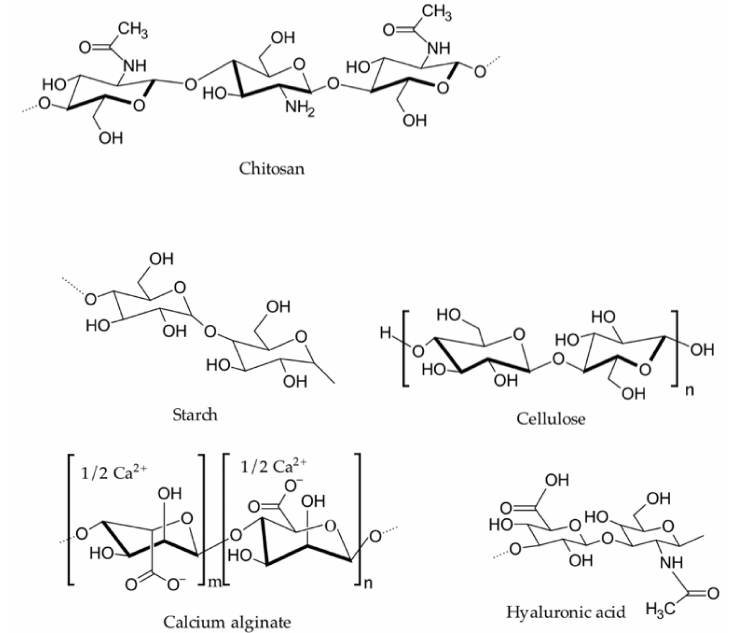
Figure 1. Representative chemical structures of naturally occurring hemostatic